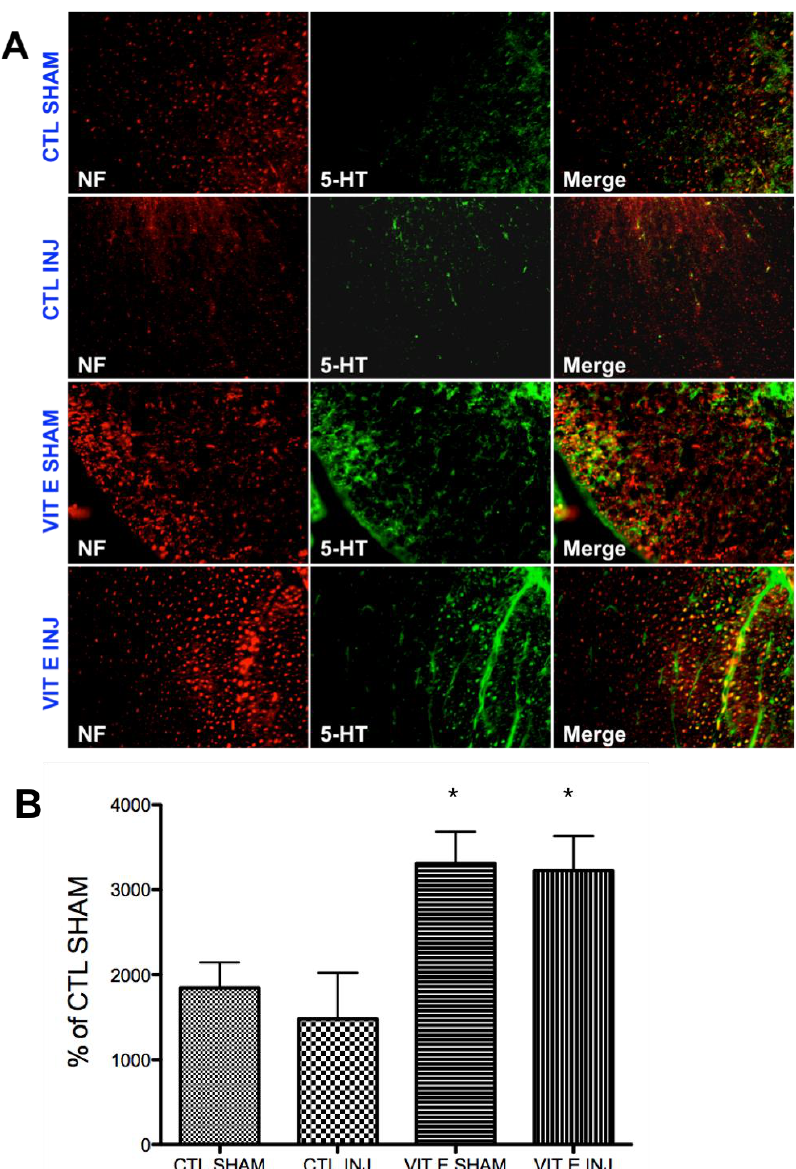
Figure 7. Vitamin E prophylaxis upregulate serotonin immunoreactivity in the white matter at 7 dpi. Serotonin IR was quantified in the white matter at 7 dpi in all four groups (Figure 7A). There was a diet-dependent upregulation of 5-HT-IR in uninjured rats (* p < 0.05, CTL SHAM, n = 5 vs. VIT E SHAM, n = 5) and injured rats (* p < 0.05, CTL INJ, n = 5 vs. VIT E INJ, n = 5) (Figure 7B). There was no difference between uninjured and injured rats in the control diet ( p > 0.05, CTL SHAM, n = 5 vs. CTL INJ, n = 5) and between uninjured and injured rats in the vitamin E diet ( p > 0.05, VIT E SHAM, n = 5 vs. VIT E INJ, n = 5). 5-HT (5-hydroxytryptamine), NF (neurofilament).